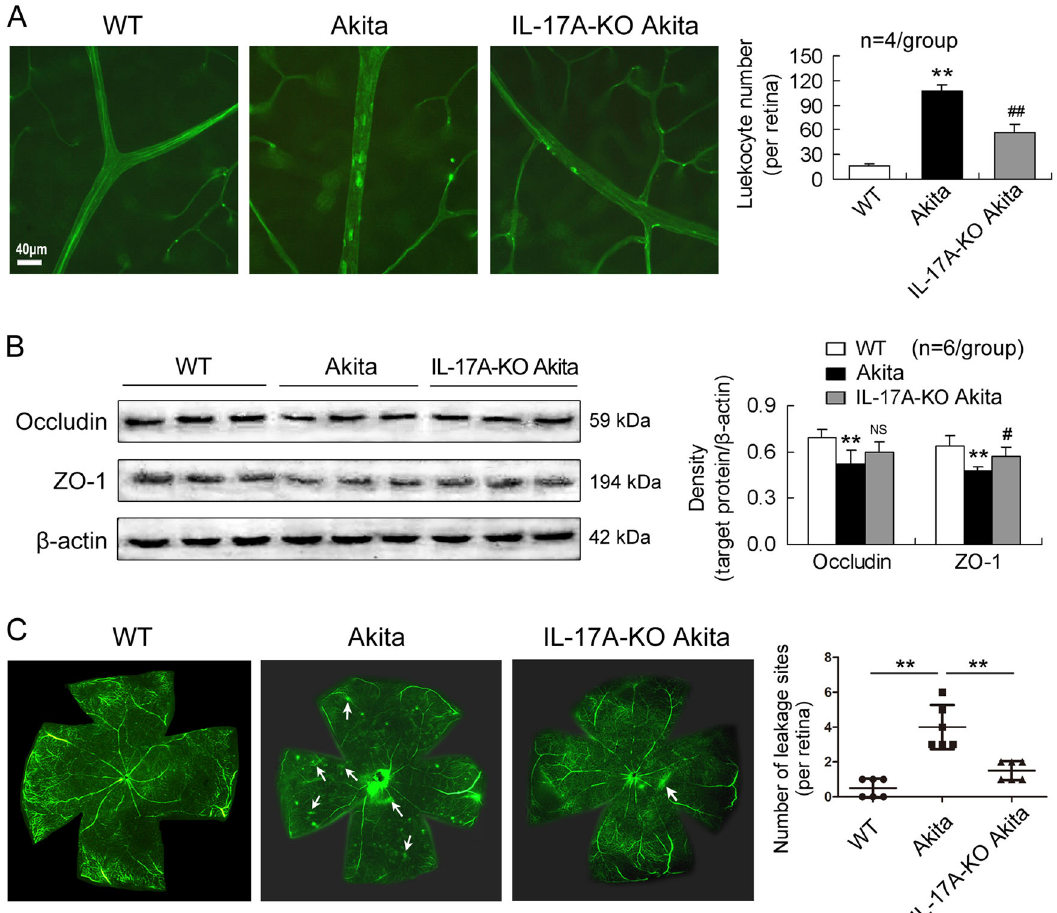
Fig. 1 Retinal microvascular lesions are alleviated in IL-17A-de fi cient diabetic mice. Male Ins2 + / − (Akita) mice 12 weeks after the onset of diabetes and male Ins2 + / − /IL-17A − / − (IL-17A-KO Akita) mice at the age of 16 weeks were employed in the experiments. Age-matched male WT mice were used as a control of Akita mice and age-matched male Akita mice served as a control of IL-17A-KO Akita. A IL-17A gene loss reduces adherent leukocytes in the retinal vessels of DR. The adherent leukocytes were labeled by FITC-conjugated concanavalin A. Total number of adherent leukocytes in vessels per retina was statistically analyzed. The data of each group were obtained from four mice. B IL-17A gene deletion upregulates the retinal expression of ZO-1 protein in Akita mice. The data in the statistical histogram were from six mice for each group. C Retinal angiography showing that vascular leakage is mitigated in IL-17A-KO Akita mice. FITC-labeled dextran was perfused and the retinas were dissected and fl at mounted. The leakage sites were counted in the retinal angiography by fl uorescence microscopy. The arrows indicate typical FITC-dextran extravasations. ** P < 0.01, versus WT mice; # P < 0.05, ## P < 0.01, versus Akita mice; NS, no signi fi cance versus Akita